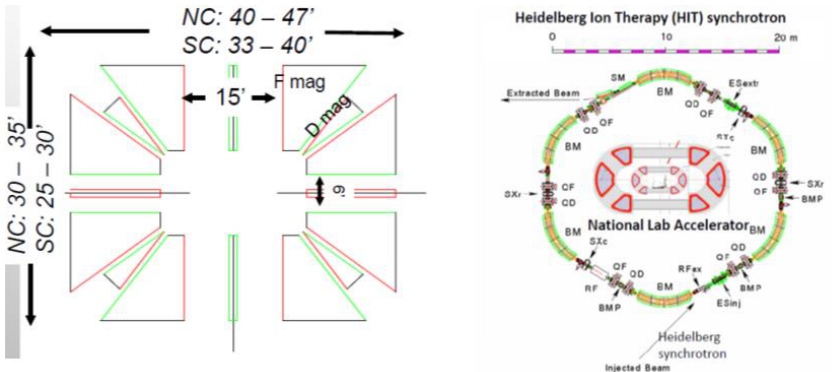
Figure 7. Outer dimensions for a variable energy 330 MeV/nucleon therapeutic ring ( left ) and a dual ring system of 430 MeV/nucleon ( right ) compared with the Heidelberg ion therapy facility. On the right, the FLASH-capable, CW, and variable-energy 430-MeV/nucleon ion accelerator nested system is compared to equivalent-energy, low-duty-cycle Heidelberg ion therapy synchrotron. Inner ring racetrack is 250 MeV/nucleon and can provide independent beam delivery.